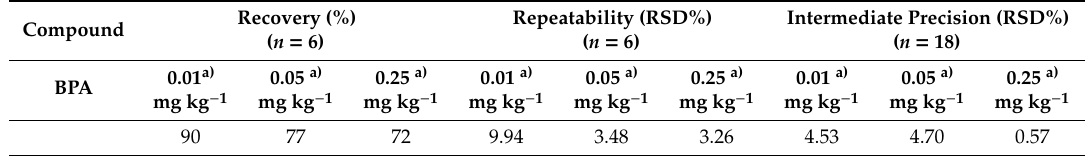
Table 4. Recovery, repeatability and intermediate precision of the HPLC-FLD method.